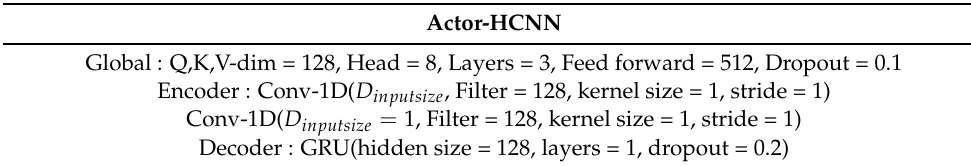
Table 4. Main parameters of the actor network.